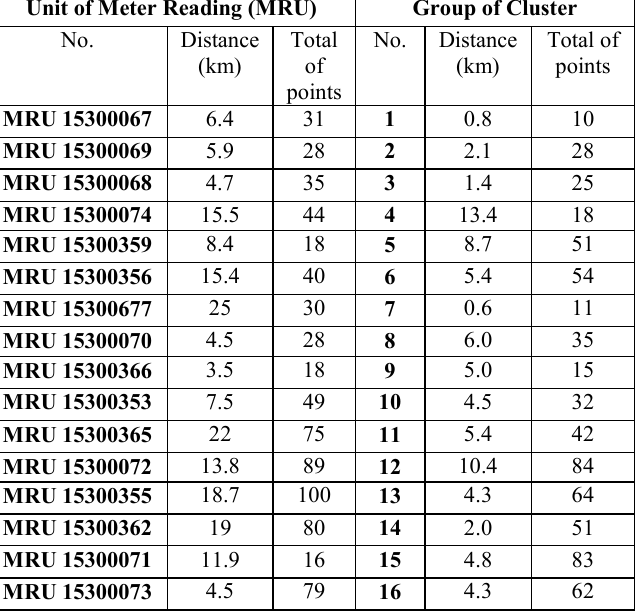
Figure 9 The shortest route directions